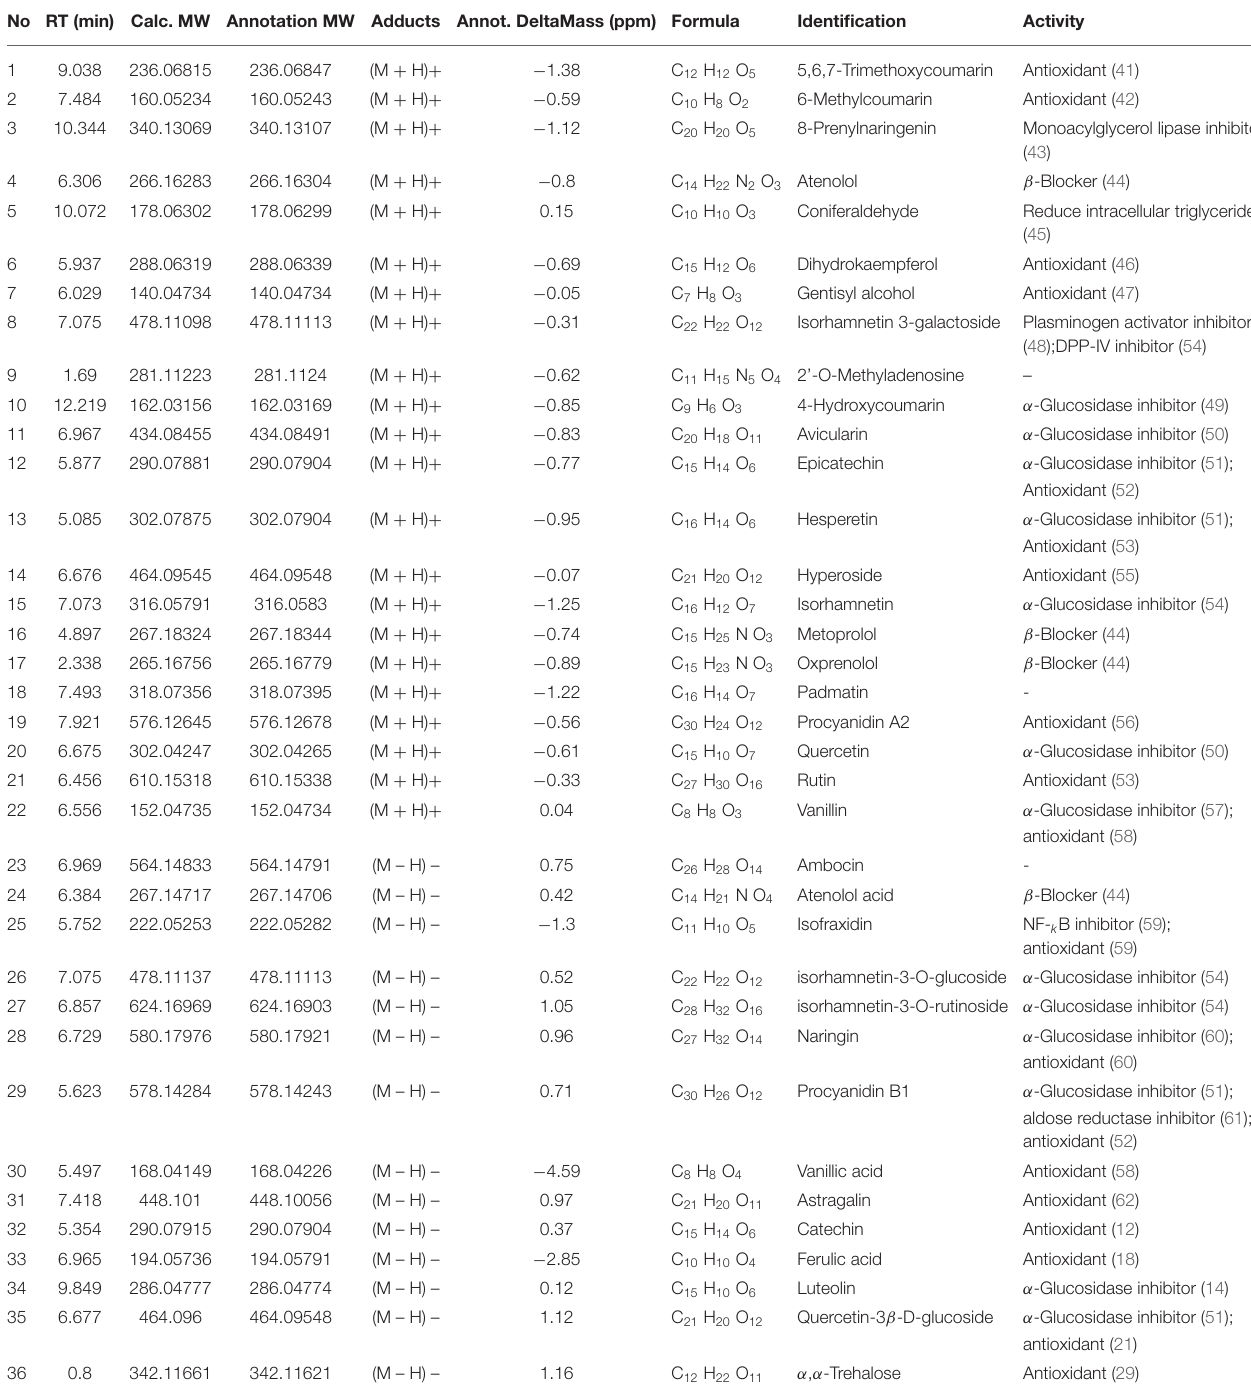
TABLE 1 | Identification of phytochemicals in PMEAT by